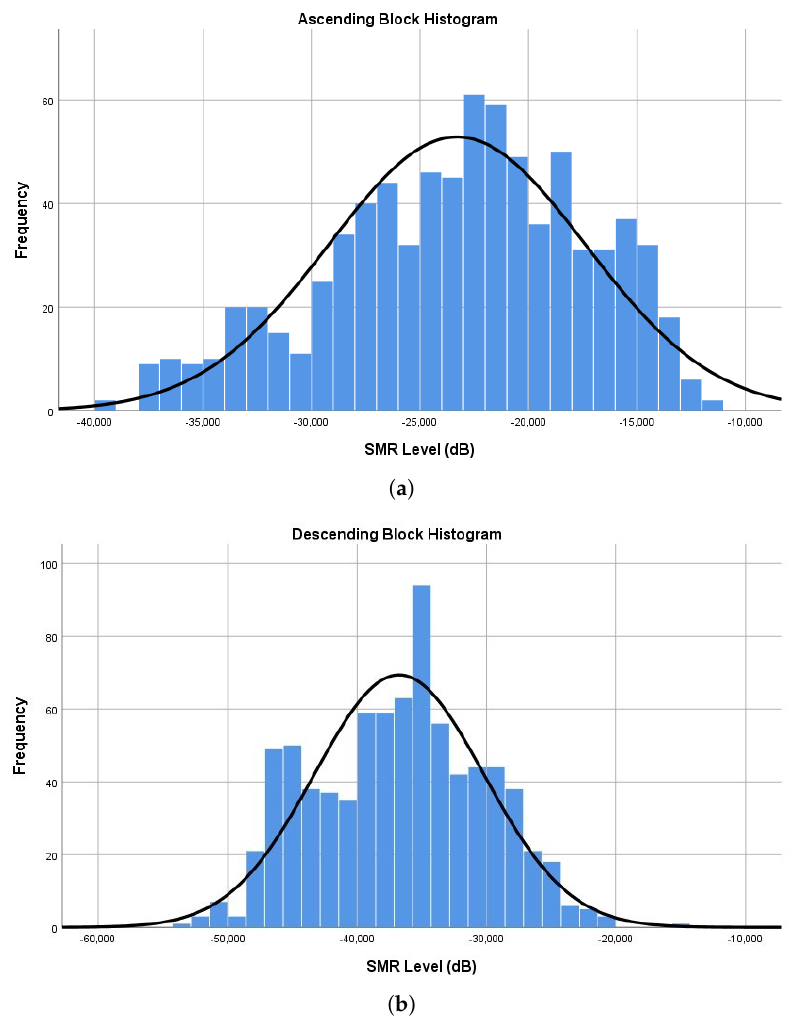
Figure 2. Histogram representation of the obtained SMR levels (in dB). ( a ) Ascending block. ( b ) De- scending